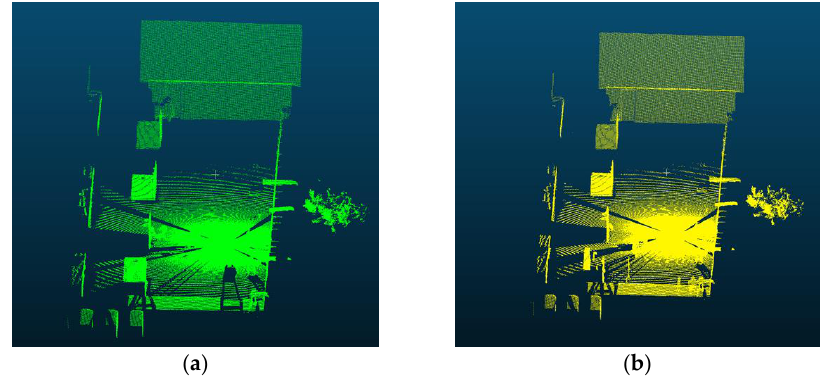
Figure 10. Reference and deformation point cloud data collected. ( a ) Reference point cloud data; ( b ) deformation point cloud data.